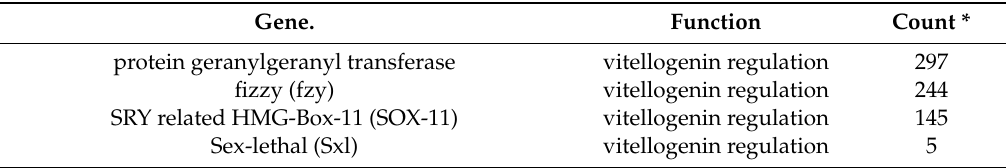
Table 1. Cont. Gene.